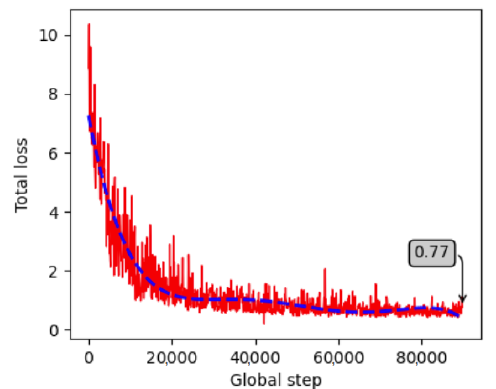
Figure 17. Progress of the training loss for the created dataset in the real industrial environment.